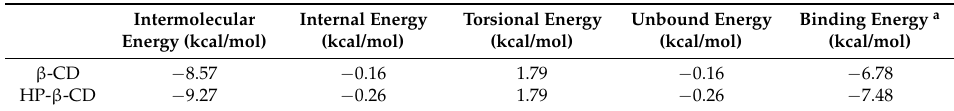
Figure 5. Docking calculation results and proposed favorable mode of the inclusion complex ( a ) top view from the wide rim of oxyresveratrol- β -CD; ( b ) side view of oxyresveratrol- β -CD; and ( c ) stick molecular representation of oxyresveratrol- β -CD ( A ); ( a ) top view from the wide rim of oxyresveratrol-HP- β -CD; ( b ) side view of oxyresveratrol-HP- β -CD; and ( c ) stick molecular representation of oxyresveratrol-HP- β -CD ( B ). In yellow, hydrogen bonds. Table 3. The lowest energy values for the complex of oxyresveratrol and different CDs based on Autodock results.